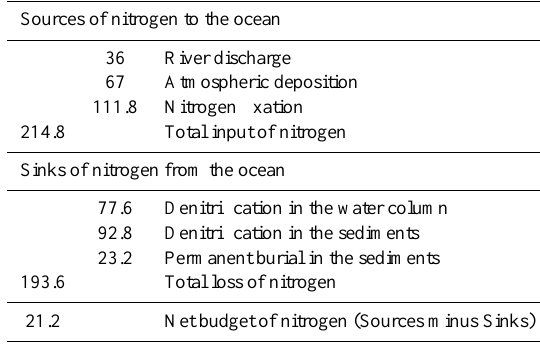
Table 5. Global annual budget of calcite and Si in the top 150m of the ocean.